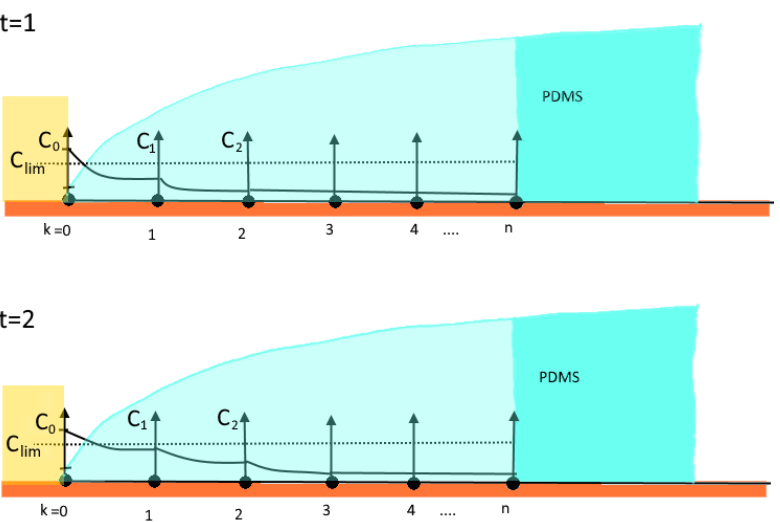
Figure 10. The beginning of the interface diffusion. The diffusion range is discretized in finite elements. At t = 1 the interface diffusion is at the starting state, only affecting the first element. In the second stage, due to the coupling of the nodes, the concentration begins to spread into the next element. Corrosion in the first element has progressed so far that in t = 3 the PDMS begins to delaminate from the copper substrate. In this way, a cavity is formed allowing the corroding agent to flow under the separated PDMS. Furthermore, the corroding agent directly affects the next element leading to a jump in concentration. This marks the beginning of the conversion of the curve from a saturation-like shape into a linear-like behaviour.